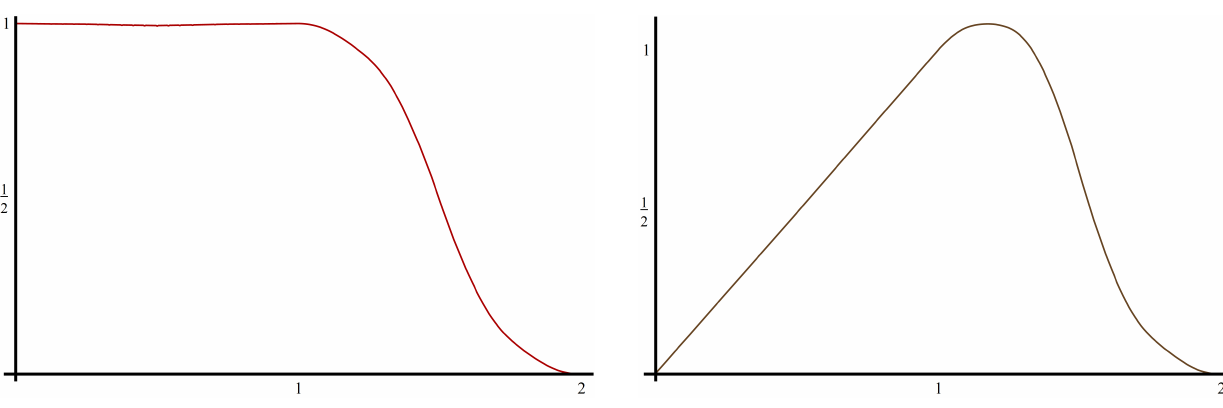
Figure 4. The edge functions, φ